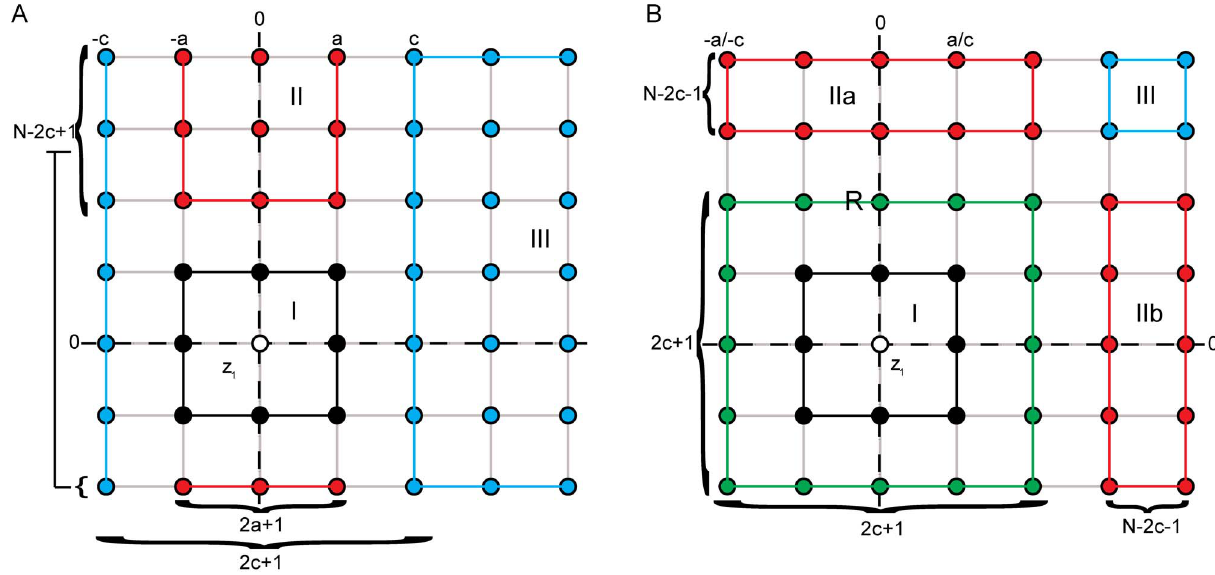
(cid:4) (cid:5) 2 2 a i ! . i